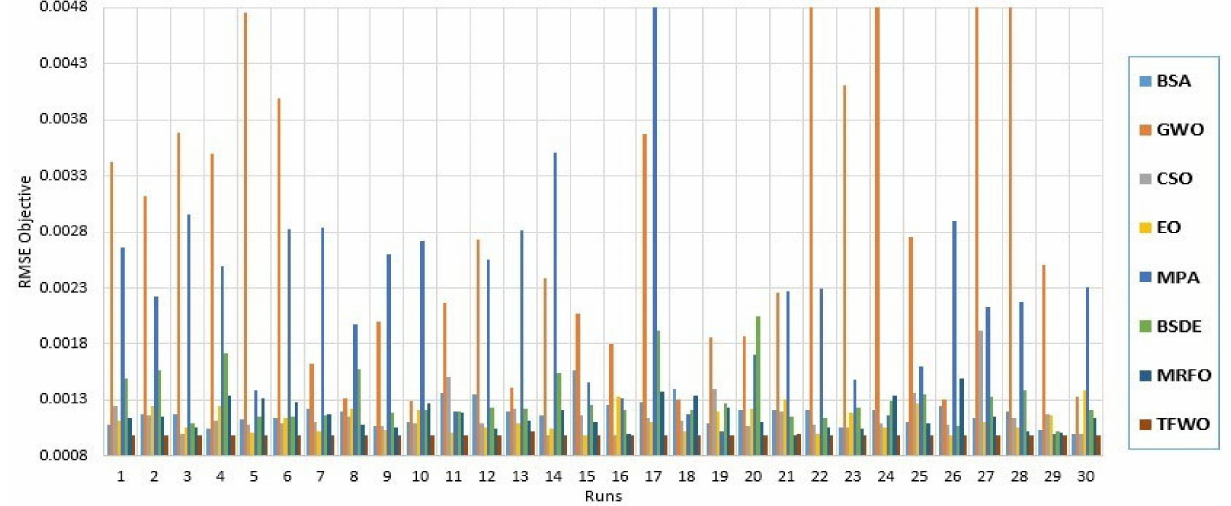
Figure 16. The RMS values of the 30 runs for R.T.C. France